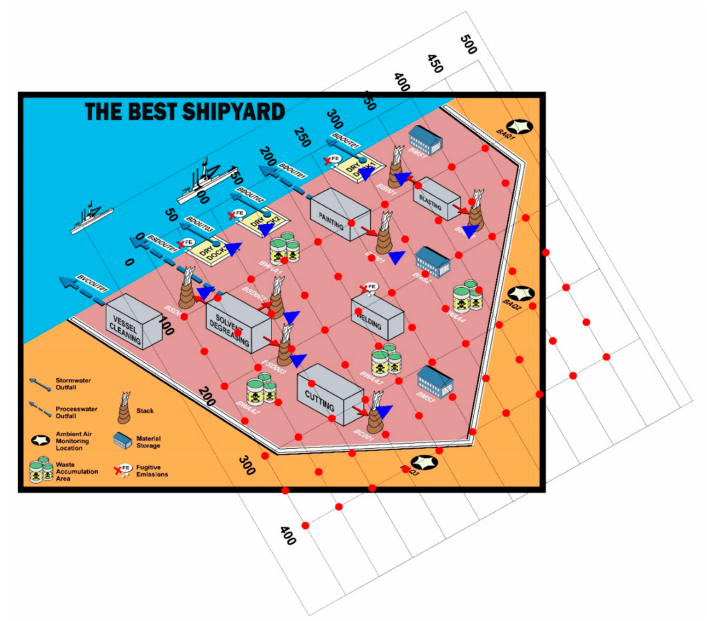
Figure 3. The Best Shipyard case with the grid superimposed in MATLAB. The triangles and circles depict sources and receptors